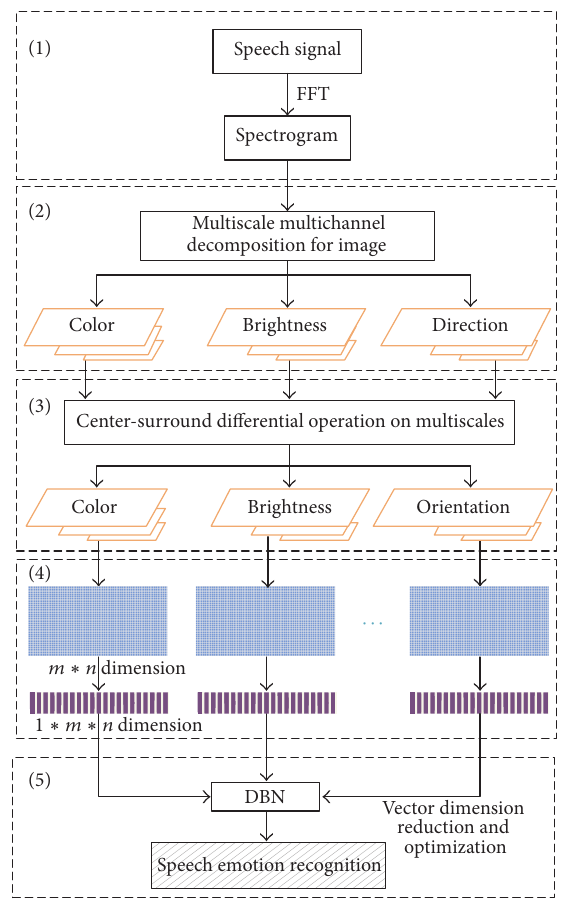
Figure 1: Spectrogram feature extraction process in